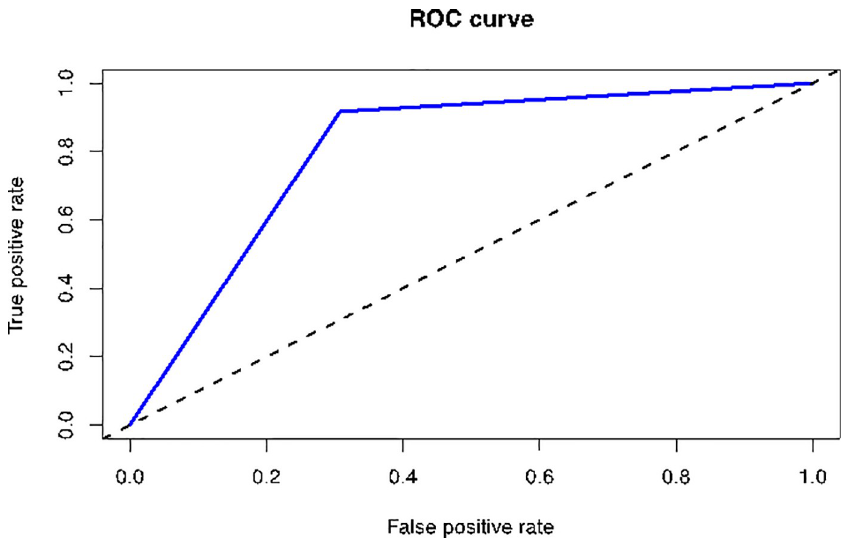
Fig 1. Receiver operating characteristic curve of the text classification model.